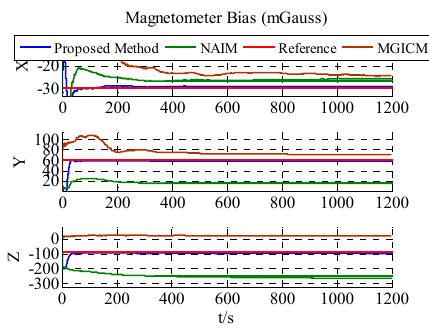
Figure 6. Estimation result of magnetometer scale factors.